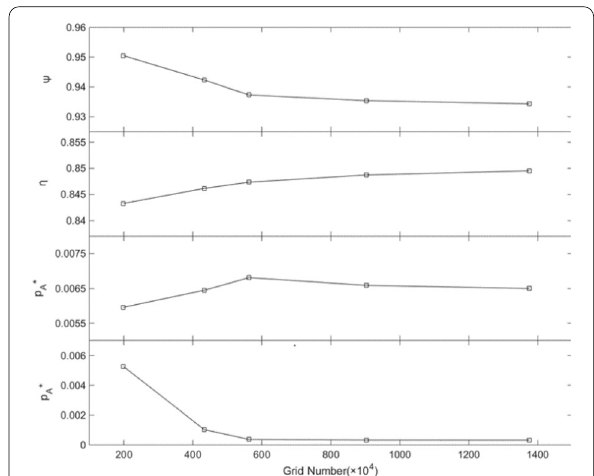
Figure 4 Results of mesh independent verification